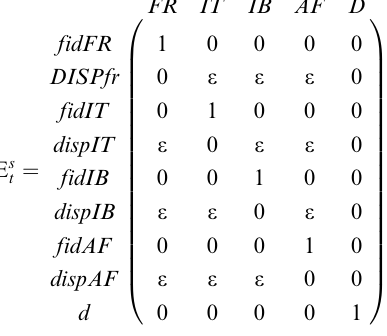
additive predictor of post-fledgling dispersal propensity did not improve QAICc (Table 2; model 27 versus model 26). When entering all SLH as individual predictors of post-fledging dispersal propensity, they were not retained as better predictors than MLH (Table 2; model 29 versus model 26; S AIC v = 0). Association between MLH and EBC, and propensity of post-fledging dispersers to disperse long distances